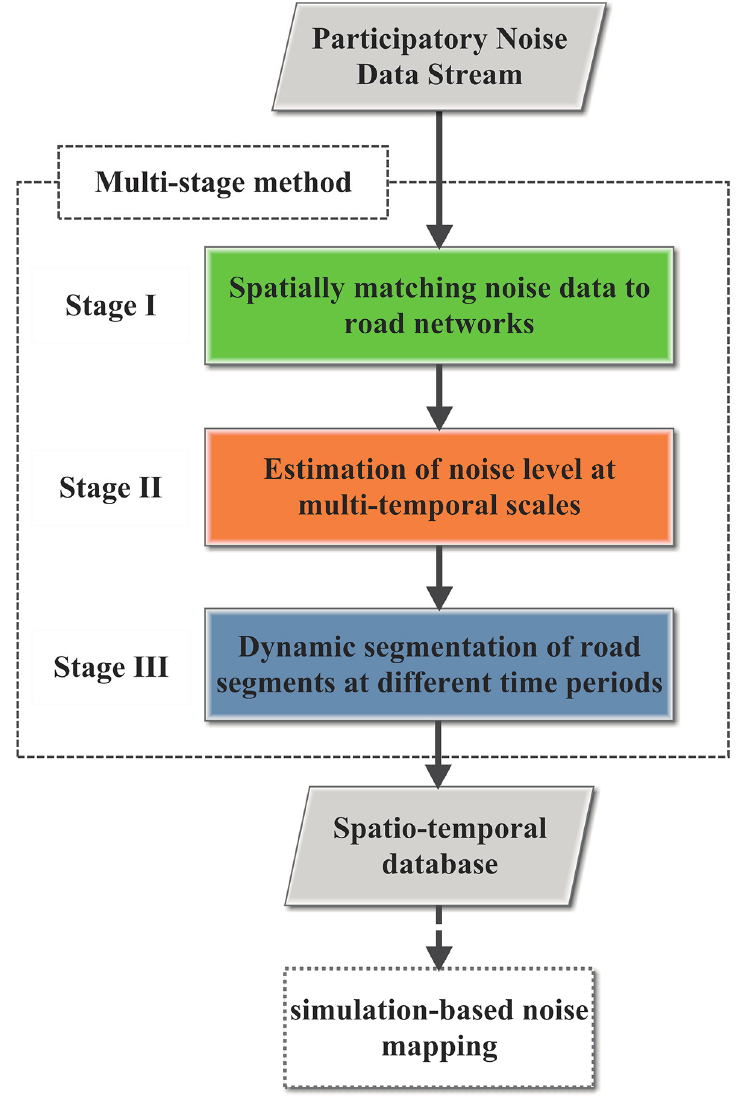
Figure 1. Framework of the multi-stage